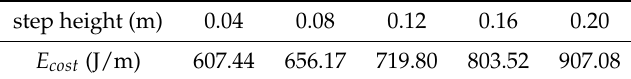
Figure 14. The energy consumptions with different step heights. Table 5. E cost with different step